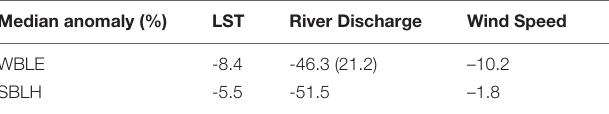
TABLE 5 | Median April anomaly values for the explanatory